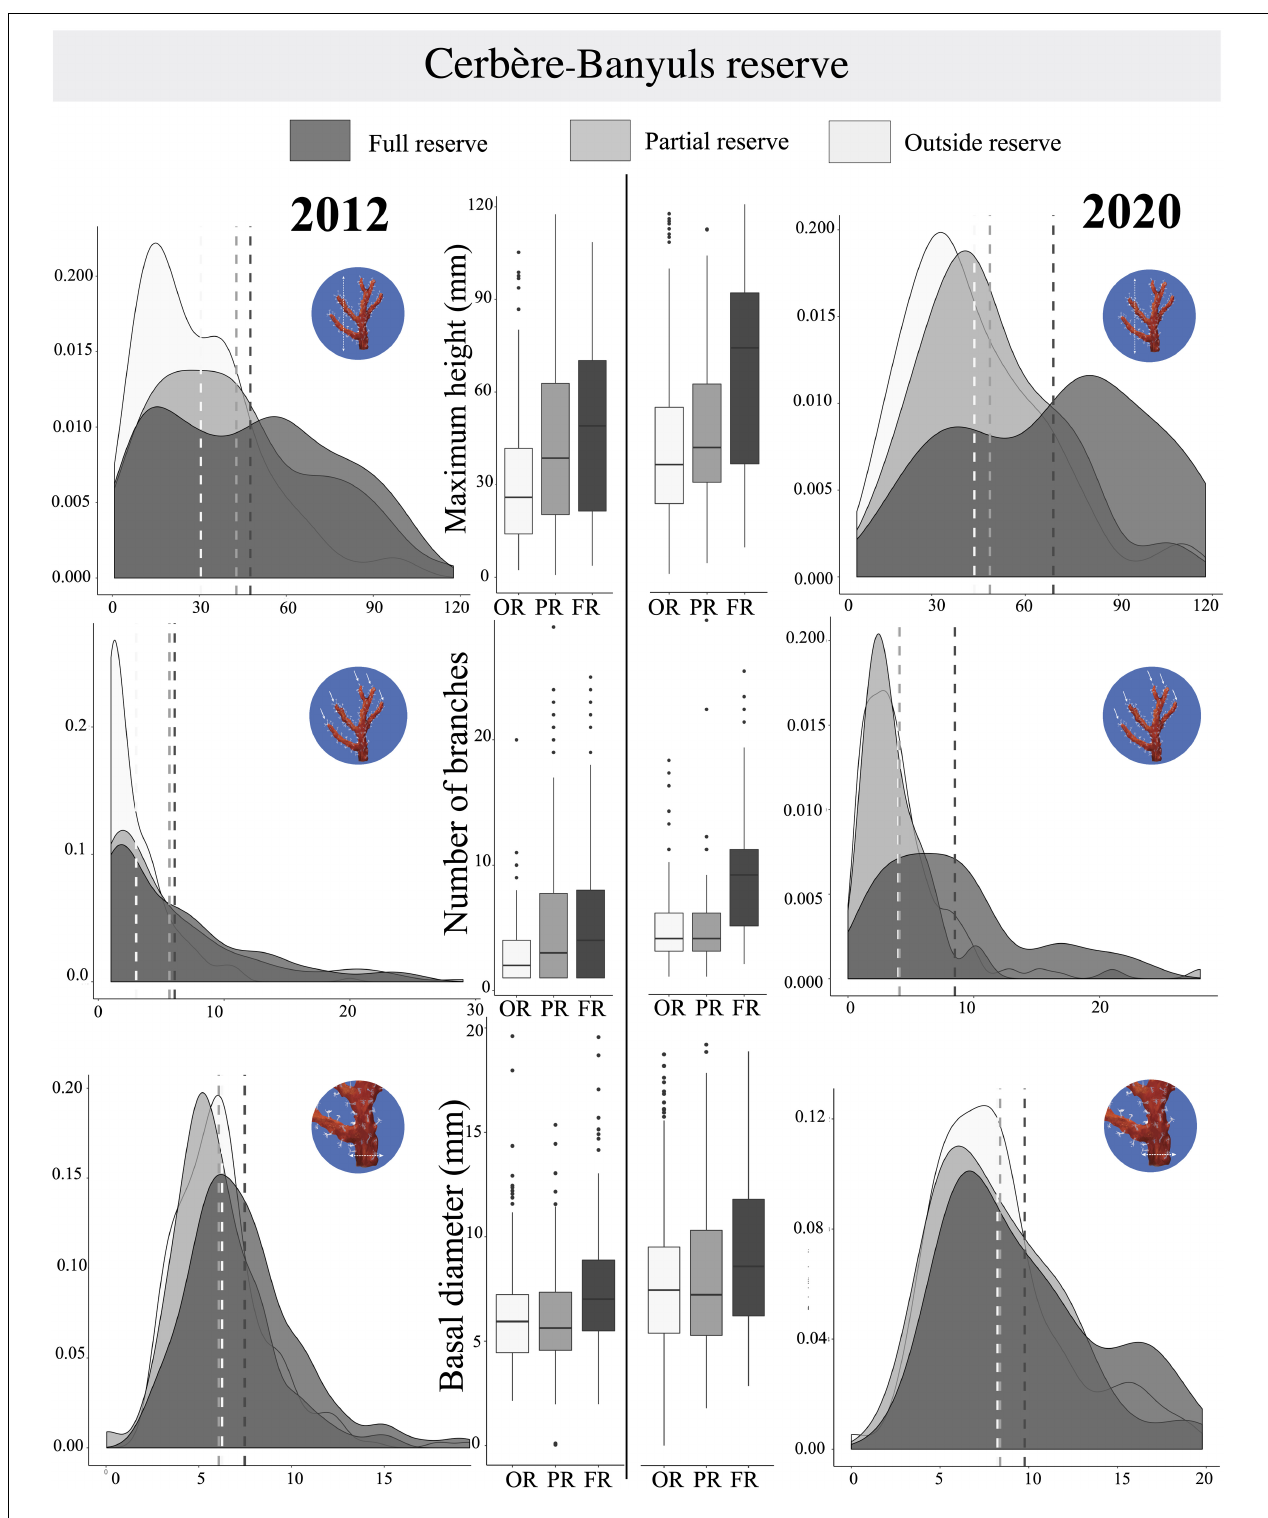
FIGURE 8 | For Cerbère-Banyuls Reserve, representation of probability density functions and Tuckey boxplots by protection levels for each year for the variables (i) Maximum height (mm), (ii) Number of branches, and (iii) Basal diameter (mm). Sites outside reserve (in clear), in partial reserve (in medium gray), in full reserve (in dark). On density functions, mean are shown in a dotted line; Boxplots indicate the median (bold line near the center), the first and third quartile (the box), the extreme values where distance from the box is at most 1.5 times the inter-quartile range (whiskers), and remaining outliers (dark circles).